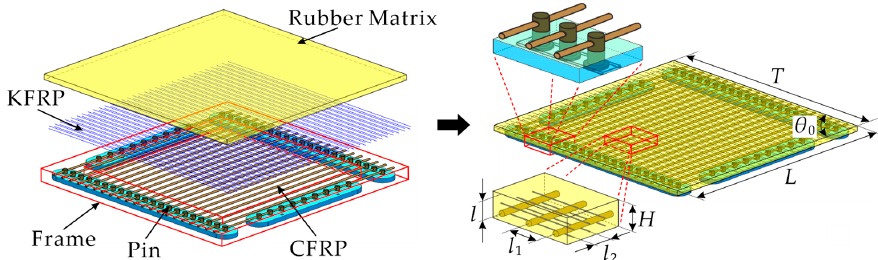
Figure 1. Design of the morphing wing skin module.